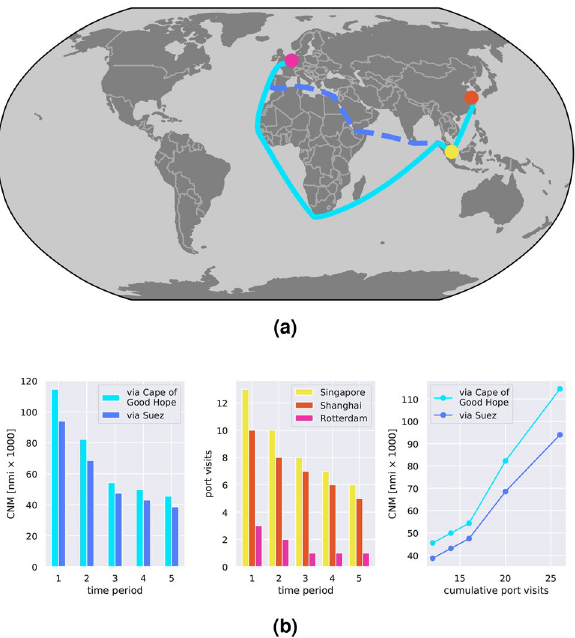
Figure 10. Relationship between CNM and PVs in a simulated environment according to Eqs. (1), (2). Three ports are considered: Shanghai, Singapore and Rotterdam. ( a ) Shows the location of the ports and their connection on the world map. Two scenarios are implemented: in the first one (solid cyan lines) ships move from Singapore to Rotterdam via the Cape of Good Hope; in the second scenario (dashed blue lines), via the Suez Canal. ( b ) Reports the outcome of the simulation. The left panel shows the CNM indicator over time in the two simulated scenarios; the mid panel depicts the simulated visits in each of the three ports; finally, the right panel reports the empirical relationship between PVs and